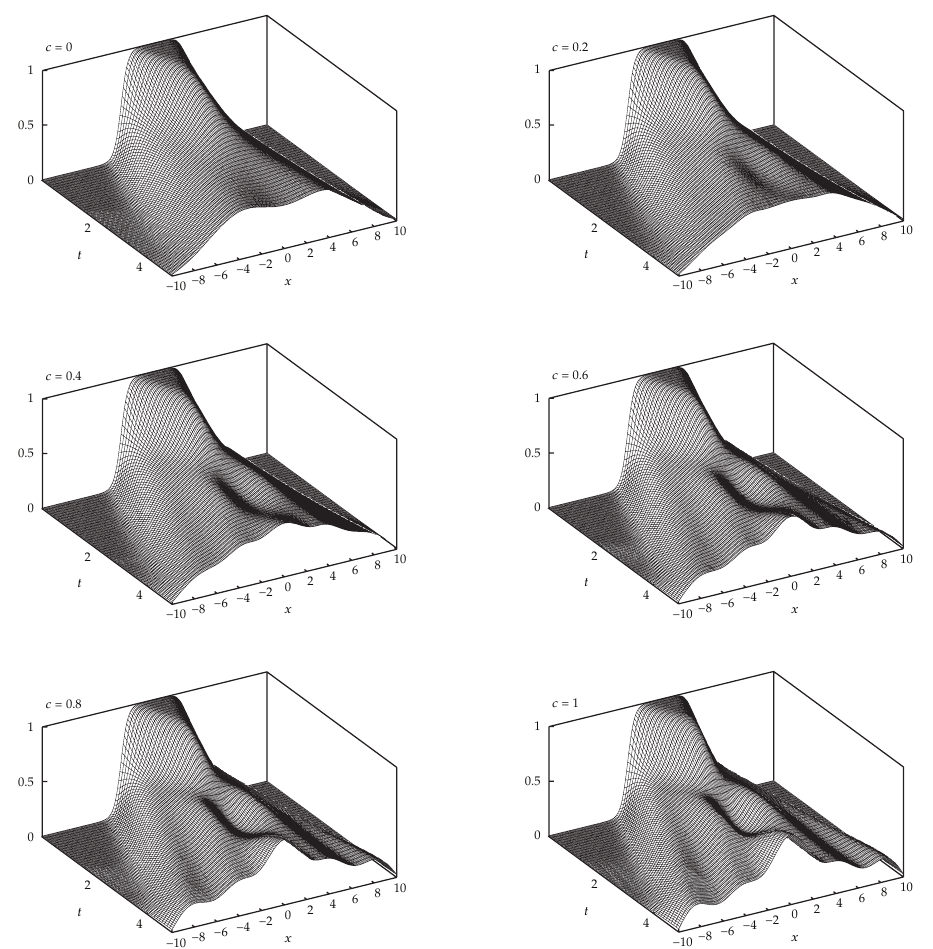
Figure 1: Numerical solution to (cid:4) 1.1 (cid:5) for α (cid:2) 1 . 5, t ∈ (cid:6) 0 , 5 (cid:7) , k (cid:4) t (cid:5) (cid:2) c · cos (cid:4) t (cid:5) , b ≡ 0. The e ff ect of the perturbation of the form b (cid:2) c · e − t , when k ≡ 0, is presented in Figure 2. As in the former case c ∈ (cid:6) 0 , 1 (cid:7) represents the intensity of perturbation. It is clear that the perturbation in such form generally increases the amplitude of the solution. The change of sign of the perturbation, c → − c , produces the opposite e ff ect, the amplitude of u (cid:4) x, t (cid:5) decreases, like in the case of